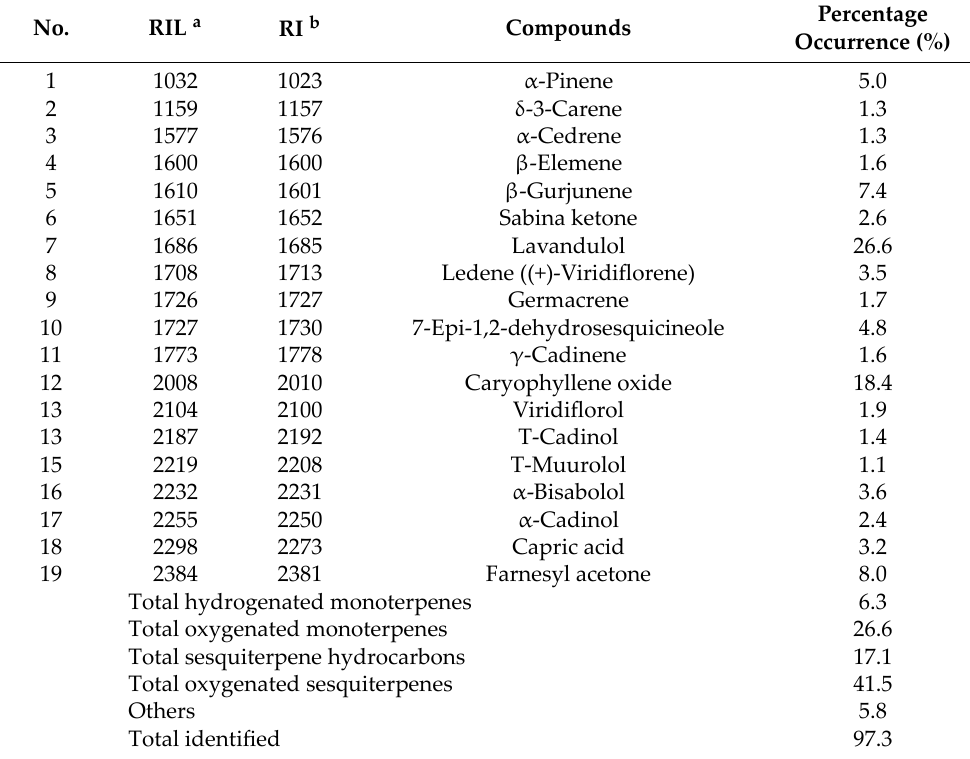
Table 3. Chemical composition of essential oil from the aerial part of Lavandula stricta